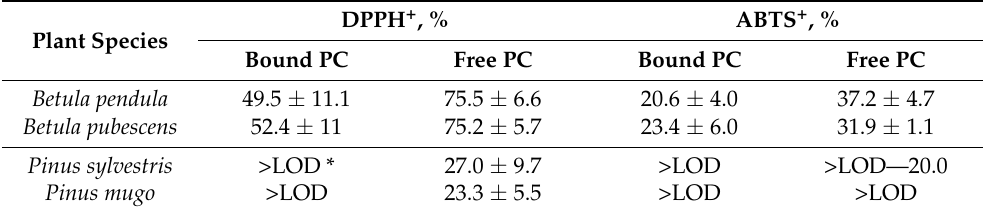
Table 3. Bioactivity of Betula and Pinus pollen compounds. DPPH + , % ABTS + , % Plant Species Bound PC Free PC Bound PC Free PC Betula pendula 49.5 ± 11.1 75.5 ± 6.6 20.6 ± 4.0 37.2 ± 4.7 Betula pubescens 52.4 ± 11 75.2 ± 5.7 23.4 ± 6.0 >LOD * 27.0 ±